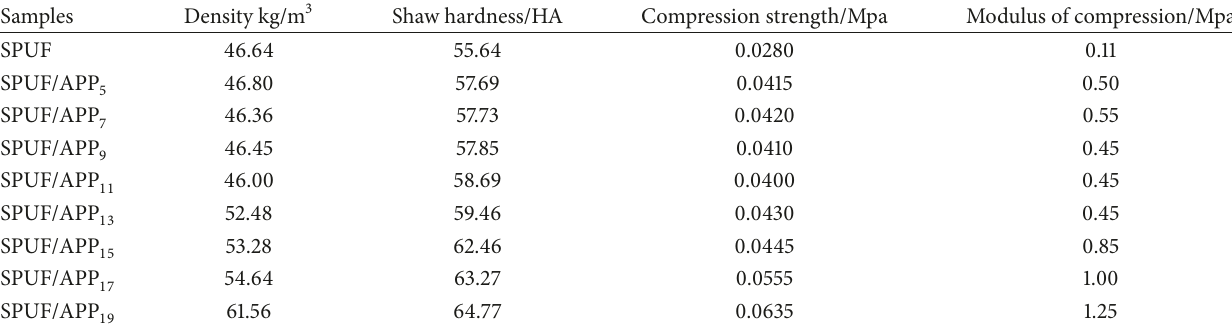
Table 3: Influence of APP on the density, hardness, and compression performance of